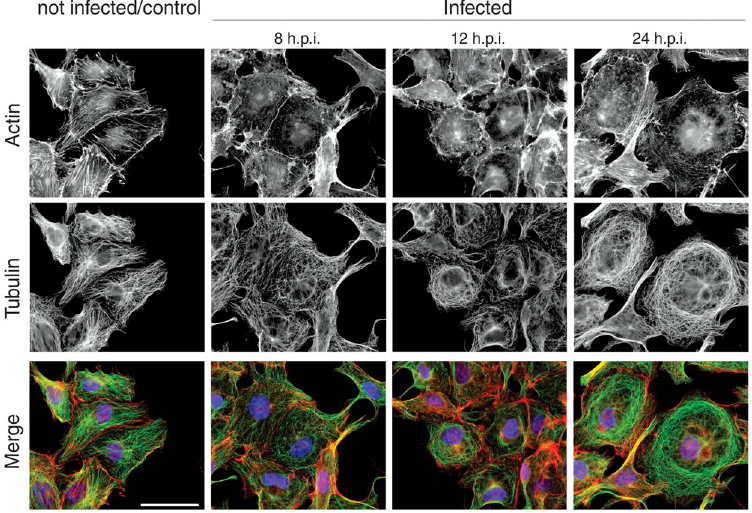
Figure 2. Time course changes in actin and tubulin cytoskeleton of PIXV-infected Vero cells. Mock-infected cells or cells infected with PIXV (MOI 0.1), were fixed at 8, 12 and 24 h p.i. and processed for IF. Actin and tubulin were visualized using phalloidin-rhodamine (red) and anti- α -tubulin antibody (green), respectively. Nuclei were stained with DAPI (blue). Note the progressive disorganization of cytoskeleton in infected cells after 8 h p.i. in comparison with control non infected cells. Scale bar: 20 µ